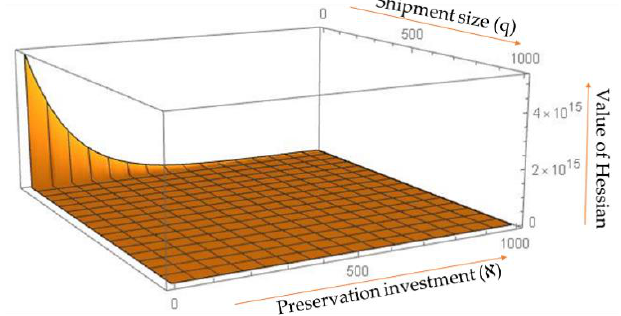
Figure A1. Graph of H (q, ℵ ).